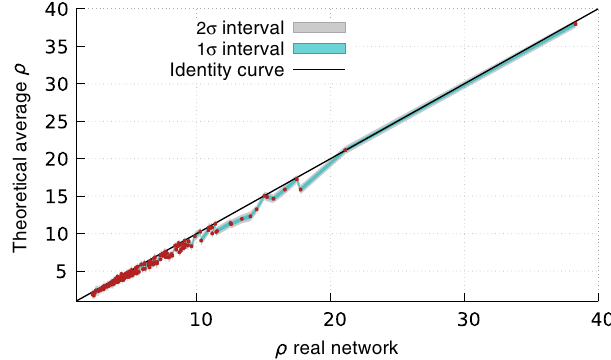
FIG. 7. Significance of the nestedness of real networks mea- sured with the spectral radius ρ . The figure shows the theoretical average value of nestedness in the statistical ensemble against the empirical measure of nestedness (red dots) for the 167 real mutualistic networks. The shadowed areas represent 1 (teal) and 2 (light gray) standard deviations of the mean.